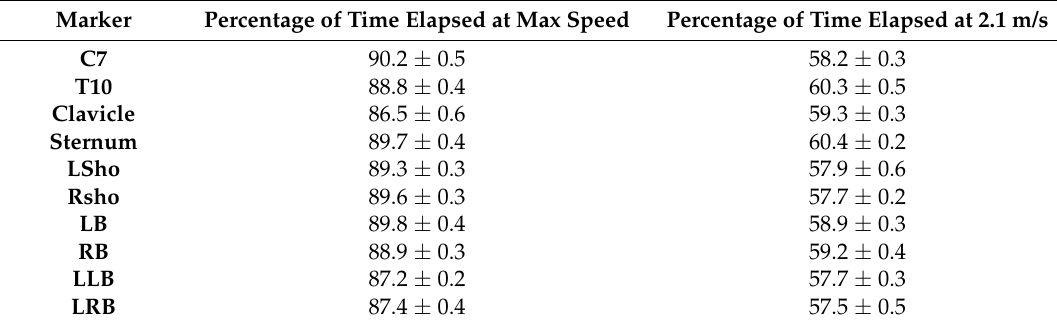
Table 2. Timing characteristics of the markers of interest during